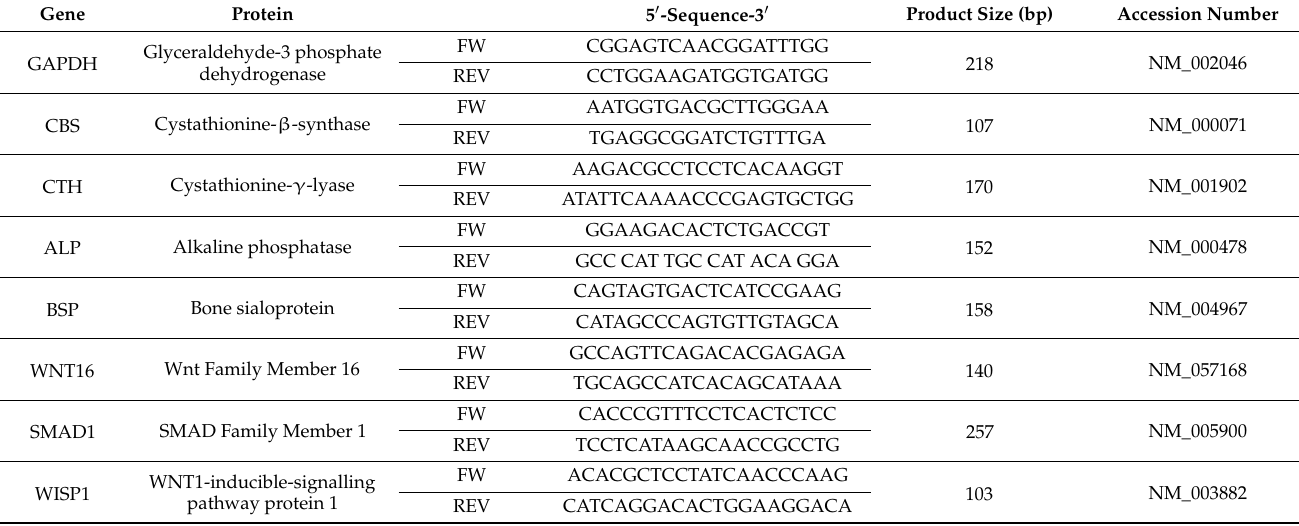
Table 1. List of primers sequences. FW: forward primer; REV: reverse